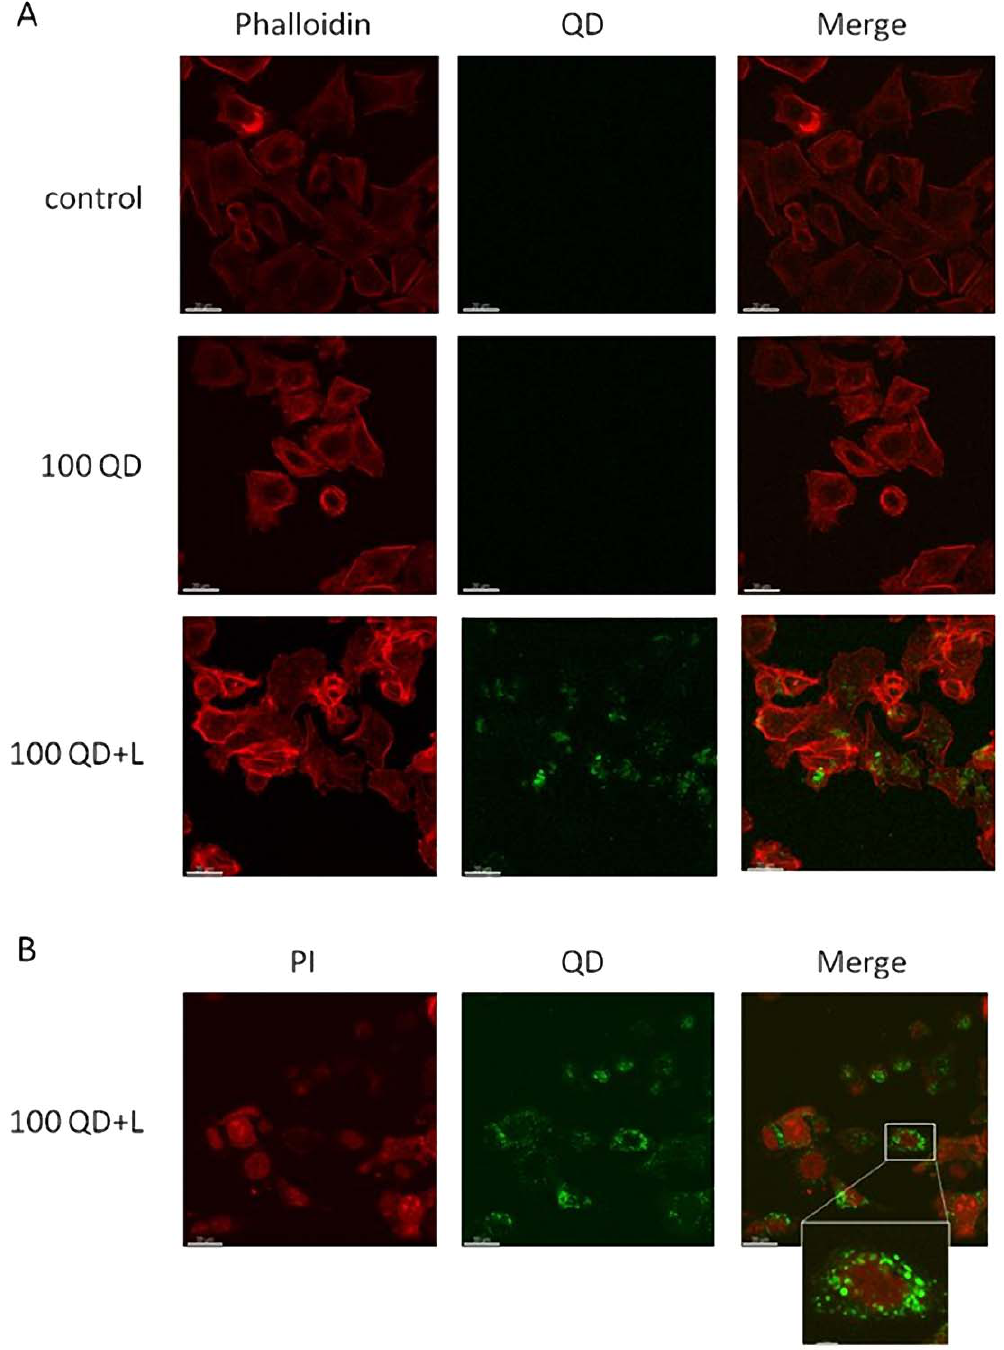
Figure 4. Uptake and intracellular localization of CdTe-GSH QDs by MKN45 cells. A, Confocal fluorescence images of MKN45 cells incubated with 100 m g/ml CdTe-GSH QDs in the absence (100 QD) or presence of lipofectamine (100 QD + L). QDs are shown in green and cell cytoplasm was stained by phalloidin (red). B, MKN45 cells incubated with 100 m g/ml CdTe-GSH QDs plus lipofectamine (100 QD + L). QDs are shown in green and cell nuclei were stained by PI (red).